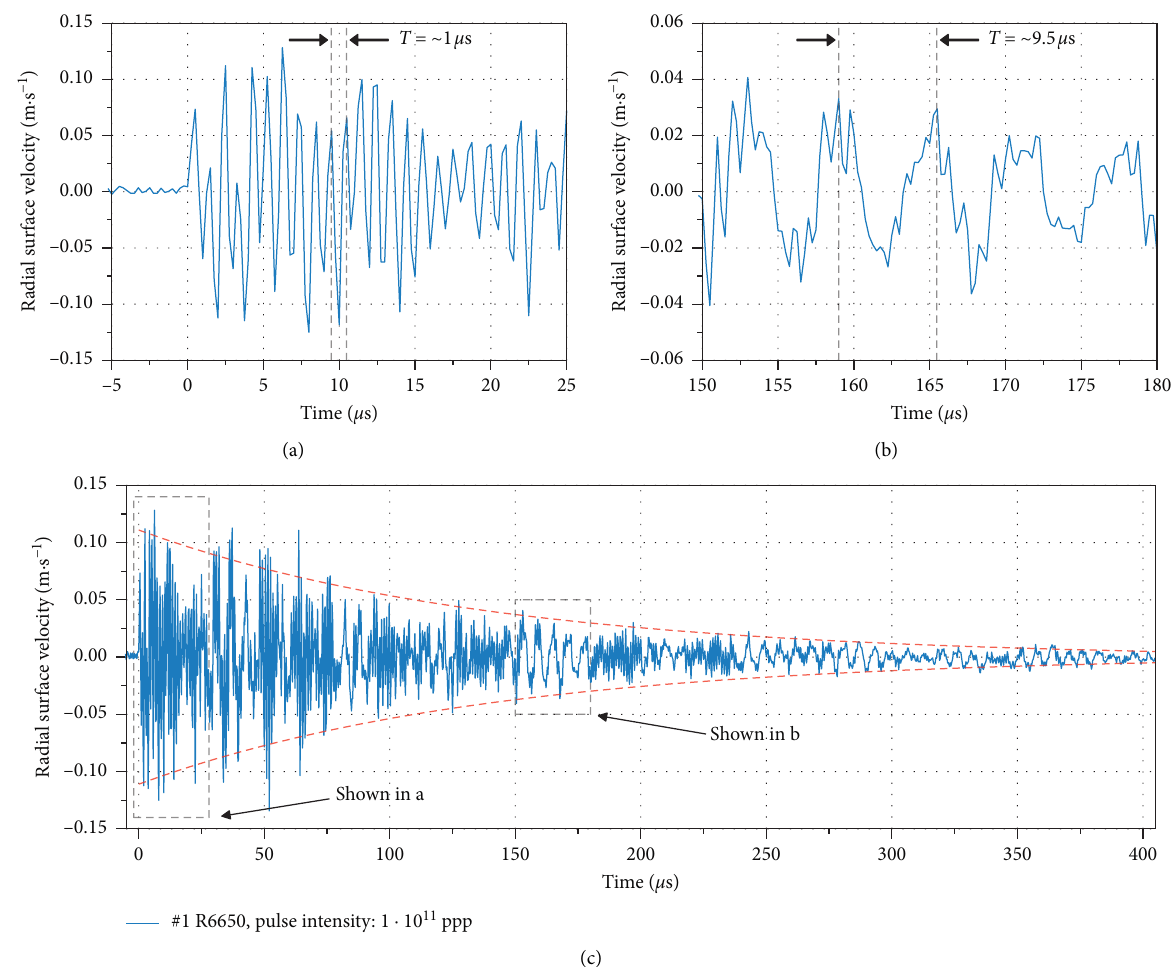
Figure 5: Radial surface velocity of target #1 R6650 after impact with 1 × 10 11 ppp (25 ns pulse length) as recorded by the LDV. Dynamic response within the first 25 μ s after beam impact (a). Response between 150 and 180 μ s after beam impact (b). Full response of the target. The dashed red lines represent a guide to the eye for the damping envelope (c).